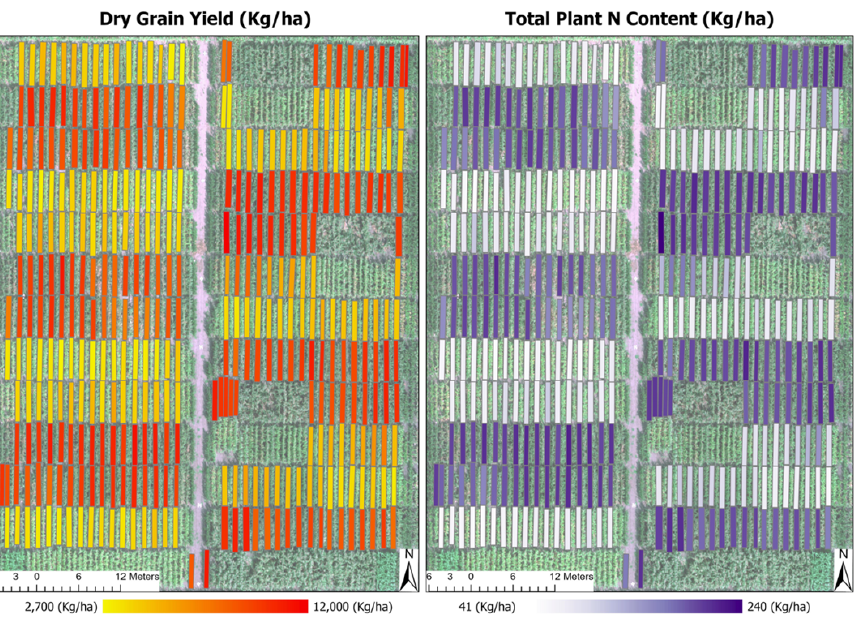
Figure 9. Spatial distribution maps of predicted dry grain yield (kg/ha) and total plant nitrogen content (kg/ha) which were the results of the multimodal and multi-task deep learning model. From the maps, it is visually detected that the distribution of predicted values clustered into plot blocks of low and high values of both grain yield and plant nitrogen content traits. These low- and high-value blocks were consistently aligned with the blocks annotated with the nitrogen experiment. It means that low-value plot blocks corresponded to the control blocks without nitrogen addition, whereas high-value plot blocks paired with the experiment blocks with 225 (kg/ha) nitrogen fertilizer per each plot. Further, the models returned the predicted values spanning within a narrower range of 2700 to 12,000 (kg/ha) for grain yield and 41 to 240 (kg/ha) for plant nitrogen content, compared to the actual values of 425 to 17,450 (kg/ha) and 26 to 314 (kg/ha), respectively (Table 3, statistics of ground truth data). This matter occurred due to the possibility of the Huber effect set as the loss of the models. Too extreme values in both ends were constrained by the Huber loss, as such, making the regression errors